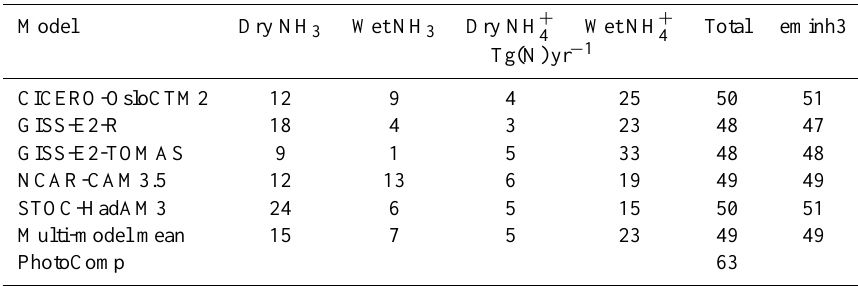
Table 3. Summary of global totals (Tg(N)yr − 1 ) for year 2000 of deposition and emissions related to the ammonia emissions. “Total” (6th column) is the sum of wet and dry deposition for NH 3 and NH 4 . “eminh3” includes anthropogenic and natural (soils and oceans) emissions. All numbers are rounded to the nearest